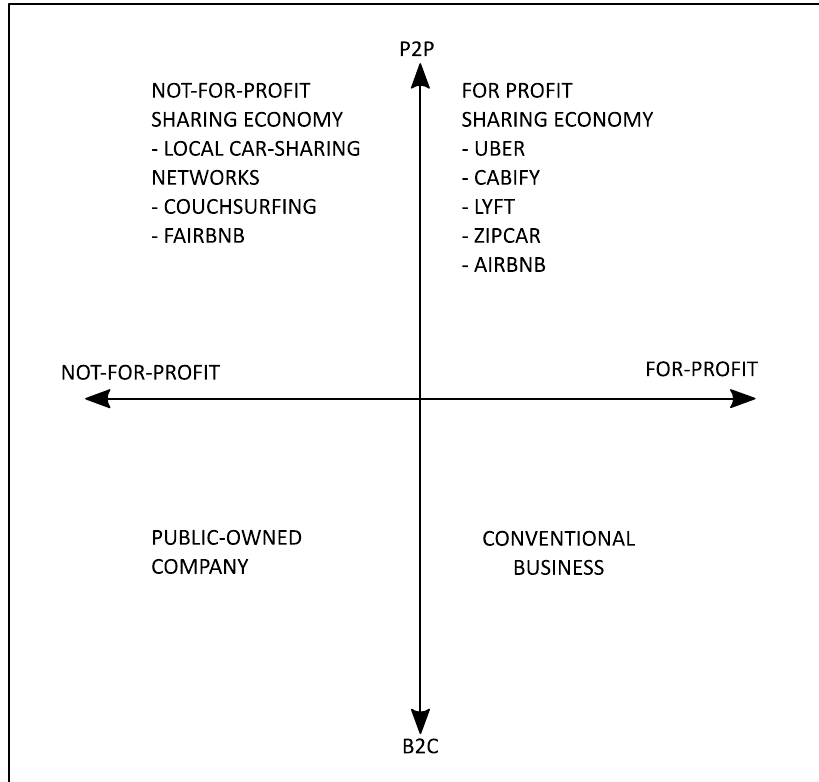
Figure 1. Sharing and conventional economy. Source: Own source adapted from Alonso (2017).